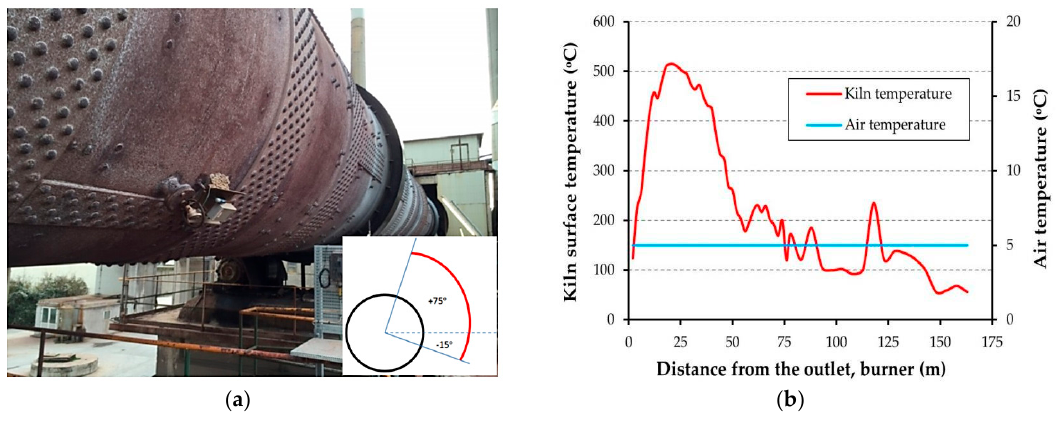
Figure 2. ( a ) Aalborg Portland cement kiln, and schematic view of the kiln and absorber; ( b ) temperature profile along the kiln’s external surface.